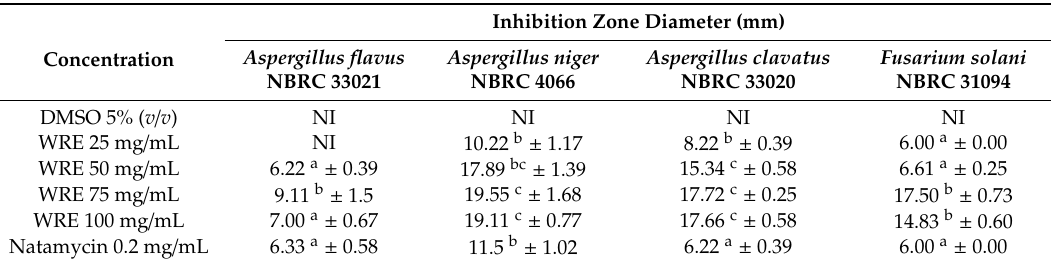
Table 2. Inhibition zone diameter (mm) for molds of white radish extract (WRE) (*).